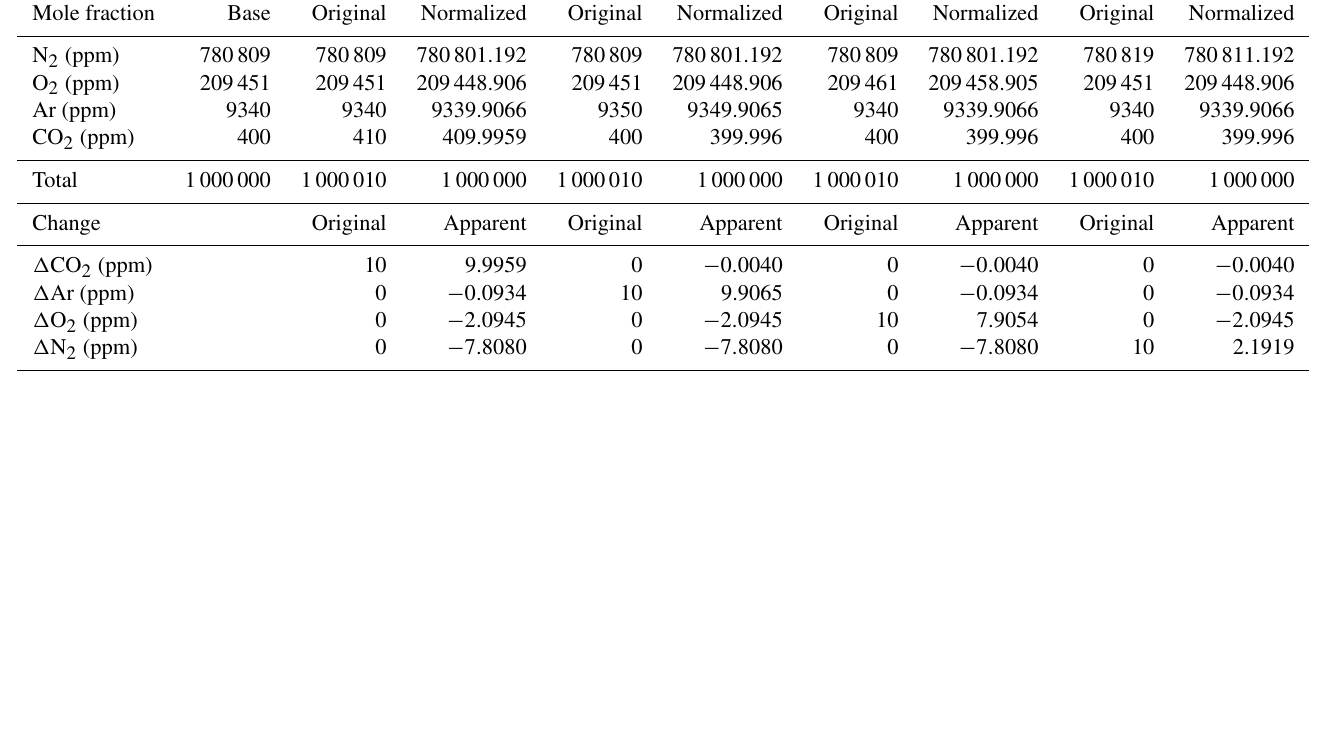
Table A1. Different dilution scenarios and their effect on air-like compositions. Mole fraction Base Original Normalized Original Normalized Original